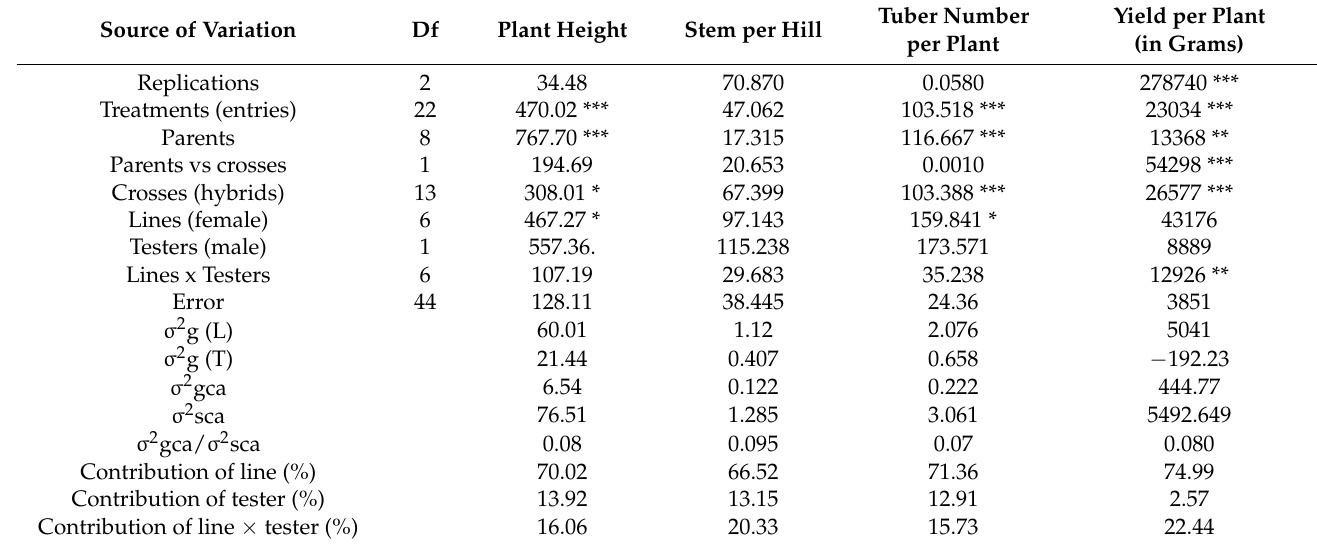
Table 4. Mean squares from line × tester analysis with parents of flowering and yield characteristics grown in BSPC during the 2020–2021 seasons.